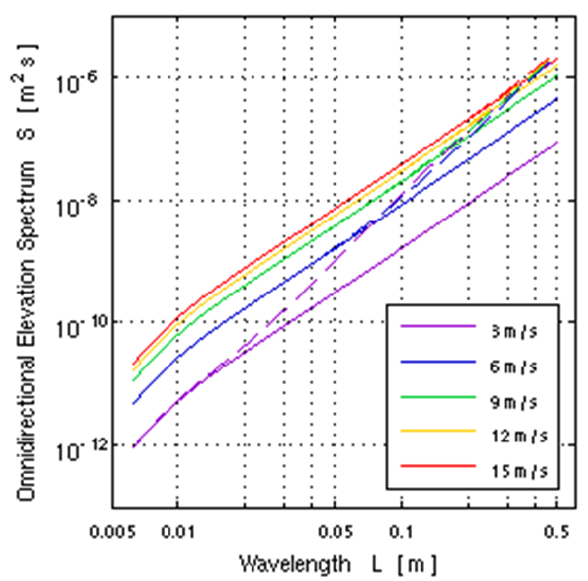
Fig. 1. Wave spectra for different local wind conditions that are used Fig. 1 : Wave spectra for different local wind conditions that are used for our near ‐ 3 for our near-surface underwater light field simulations (short-wave surface underwater light field simulations (short ‐ wave part only); the dashed lines show the 4 part only); the dashed lines show the modification due to the long- wave part of the unified modification due to the long ‐ wave part of the unified spectra. 5